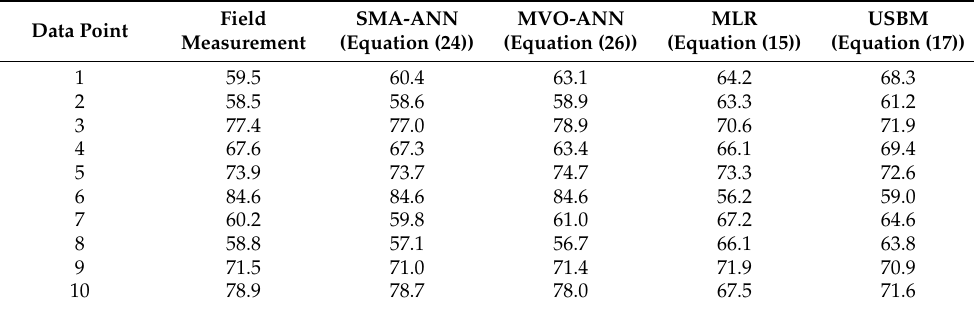
Table 5. Validation of the ANN-based equations for AOp